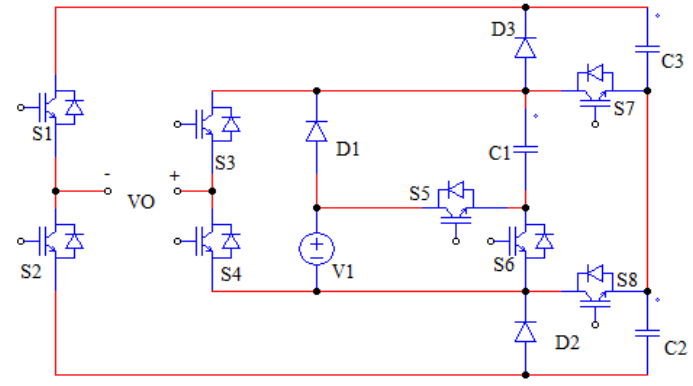
Figure 10. Eight-switch, nine-level topology [59].